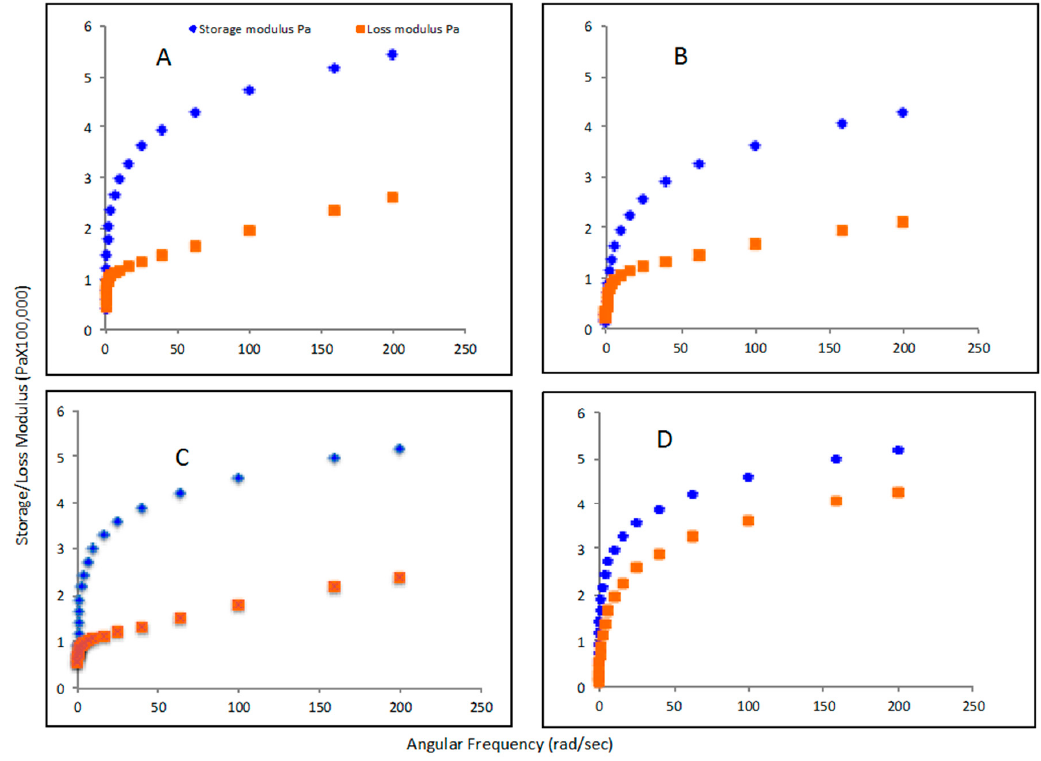
Figure 7. Storage modulus (G ′ ) and loss modulus (G ″ ) vs. angular frequency of PHA polymers synthesized by P. putida LS46123 grown on: ( A ) Hexanoic acid; ( B ) Octanoic acid; ( C ) Nonanoic acid; and ( D ) Biodiesel ‐ derived free fatty acids (REG ‐ FFAs).